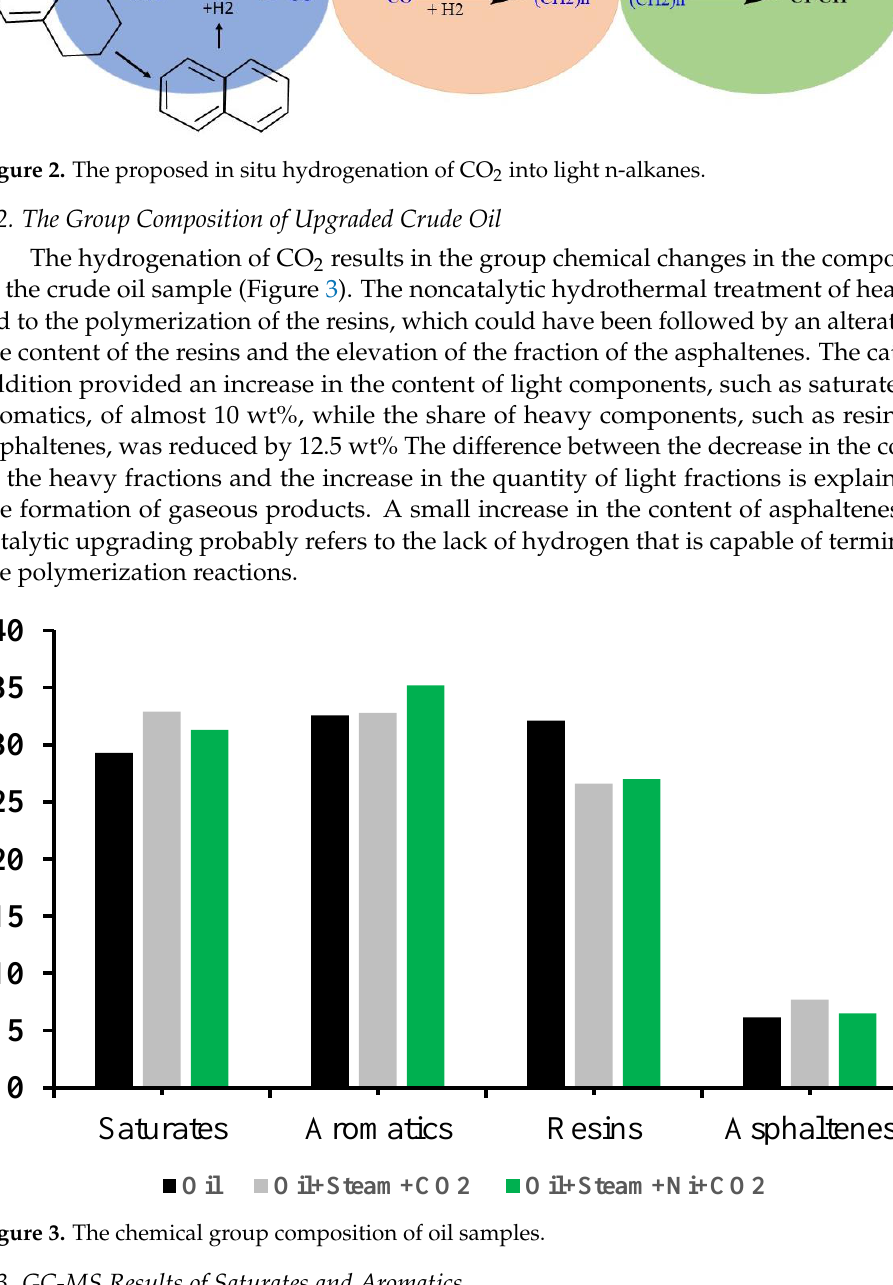
Figure 2. The proposed in situ hydrogenation of CO 2 into light n-alkanes. Table 1. The gas components which evolved after the noncatalytic and catalytic hydrothermal processes.